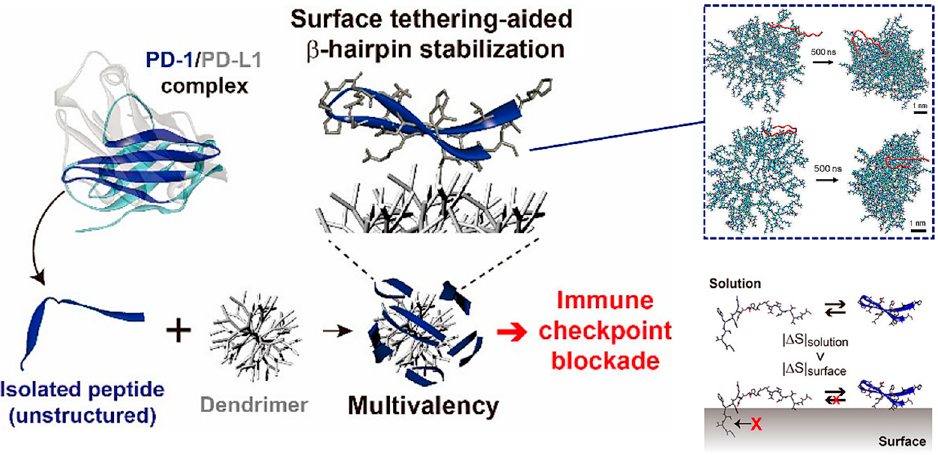
Figure 1. The peptide − dendrimer conjugate (PDC) platform has an enhanced immune checkpoint inhibitory effect due to the multivalent binding effect, and stabilizes the β -hairpin structure of the peptide via intermolecular forces and the excluded volume effect. Reproduced from Reference [23] with permission. Copyright: 2020 American Chemical Society.